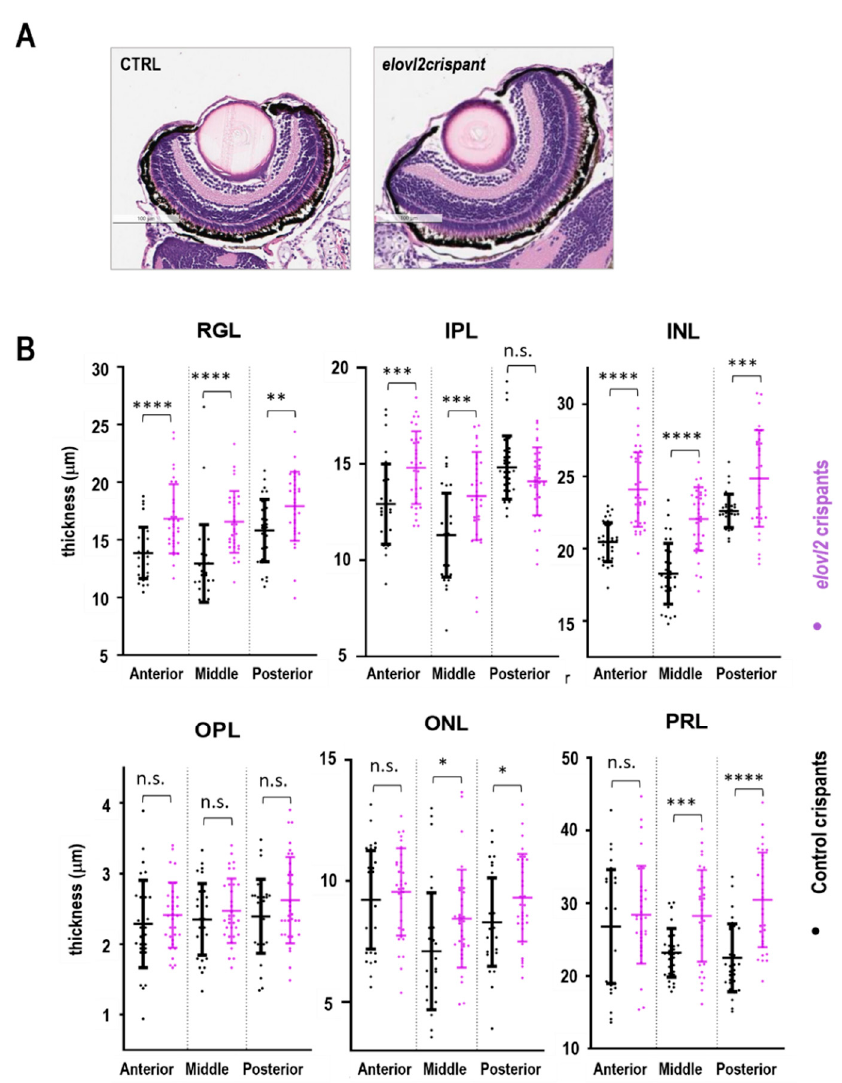
Figure 3. ( A ) H&E stained retinal sections of elovl2 and control crispants. ( B ) The thickness of the individual retinal layers of elovl2 and control crispants. Plots showing comparison of lengths of di ff erent layers in retina between control and elovl2 crispants. The measurements were taken at three di ff erent regions in the retina termed as anterior, posterior, and middle. RGL, Retinal Ganglion Cell Layer; IPL, Inner Plexiform Layer; INL, Inner Nuclear Layer; OPL, Outer Plexiform Layer; ONL, Outer Nuclear Layer; PRL, Photoreceptor Layer. (* p < 0.05; ** p < 0.01; *** p < 0.001; **** p < 0.0001, ns—not significant). Each dot is a single cryosection.